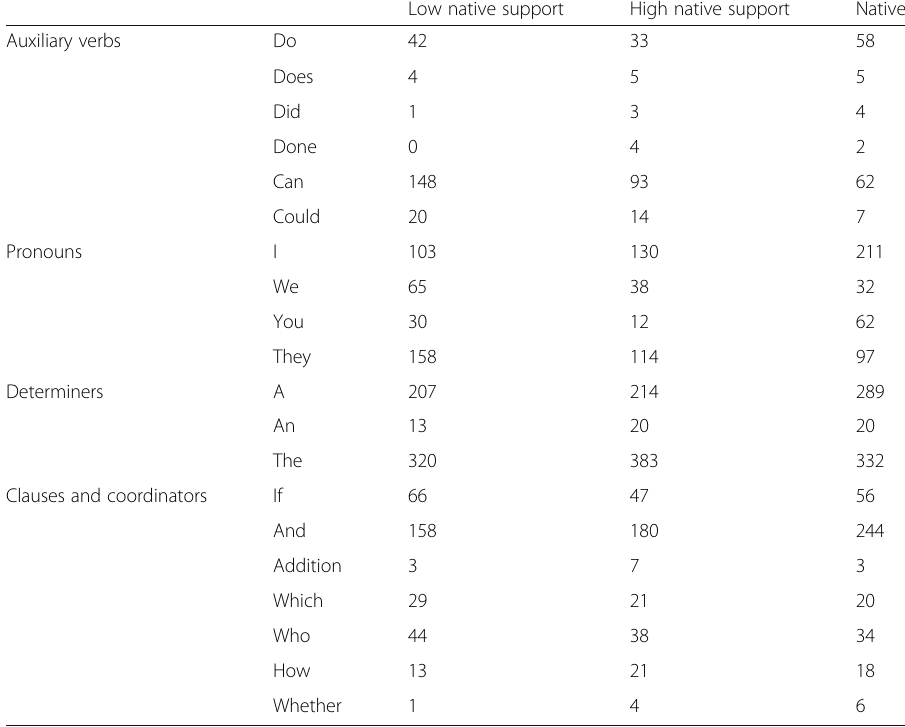
Table 5 Selected indicators for verb, noun, and clause use